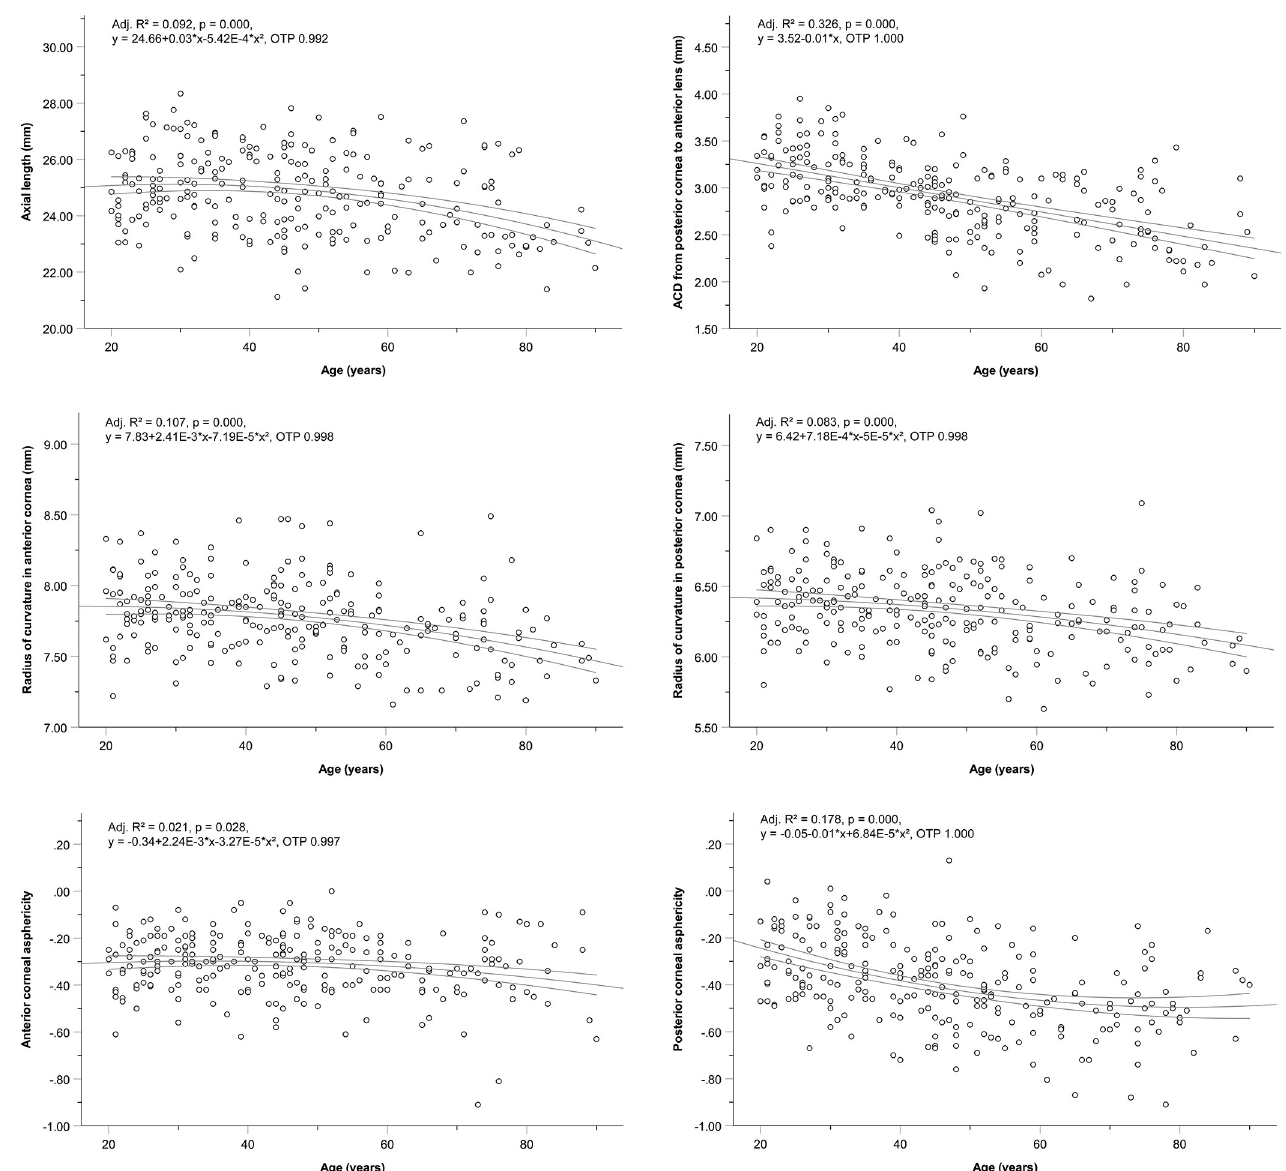
Fig 2. Ocular biometry. Age-associated changes for each study parameter (only significant correlations from Table 3 are shown). (a) Axial length (AL); (b) Anterior chamber depth (ACD) from the posterior cornea to the anterior lens; (c) Radius of curvature of the anterior cornea (ACC); (d) Radius of curvature of the posterior cornea (PCC); (e) Anterior corneal asphericity (ACA); (f) Posterior corneal asphericity (PCA). The three lines represent regression curves and 95% confidence intervals. Adj. R 2 , adjusted R 2 ; OTP, observation test power.